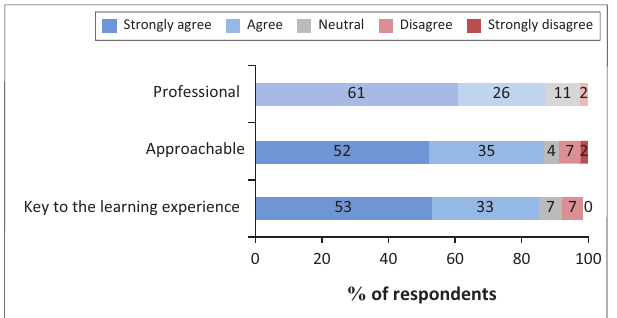
FIGURE 2: Perceptions of supervisors and supervision at decentralised clinical training sites.